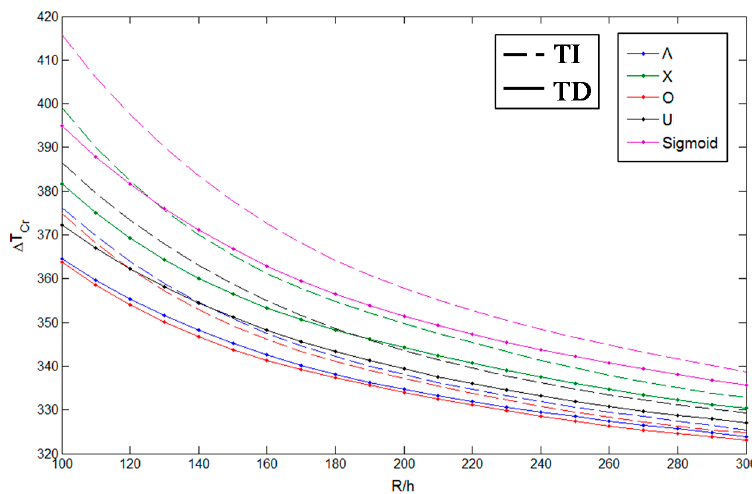
Figure 3. Effect of different CNT profiles on the critical thermal buckling load considering = 0.17, A = 1000, w = 0, N r = N s = 0. TI: temperature-independent; L / R = 2, V ∗ R CNT TD: temperature-dependent.